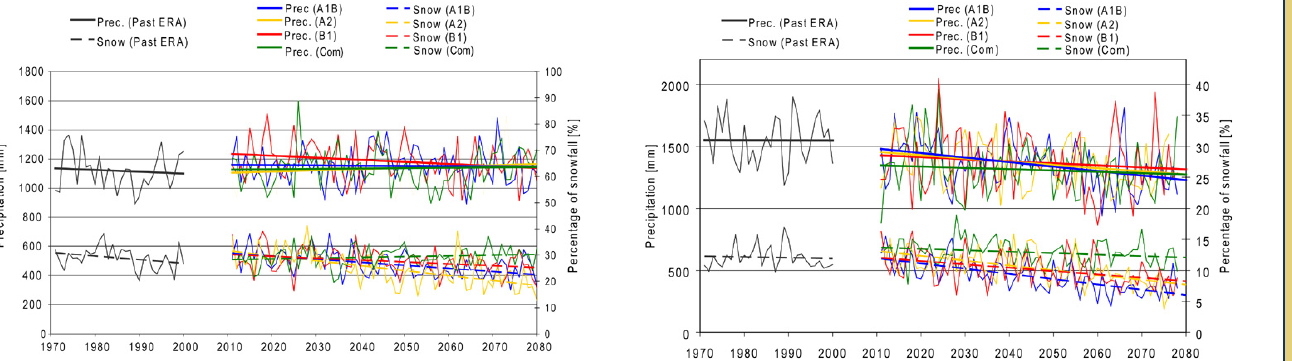
Figure 12. Development of the annual precipitation sum and the percentage of snow precipitation in the UBRB for the past and the four IPCC SRES scenarios from